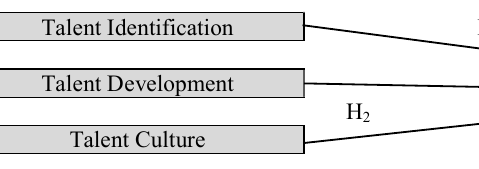
Fig. 1. The proposed study of the